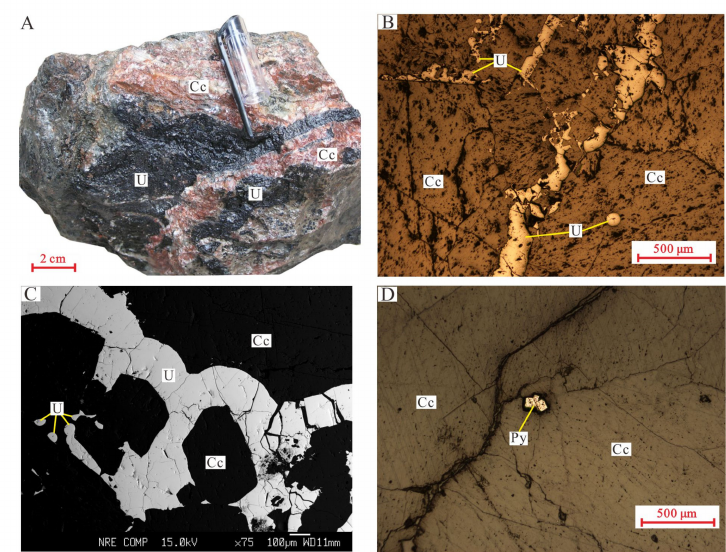
Figure 3. Vein uranium ore with calcite (Cc) as the main gangue mineral in vein-type uranium ores. ( A ): Pitchblende (U) occurs in the center or periphery of veins and forms a banded structure with carbonate minerals. ( B , C ): Pitchblende occurs in or between calcite crystals, and the crystal boundaries between pitchblende and calcite are clear and straight. ( D ): Pyrite aggregates (Py) with good crystalline morphology are encapsulated in calcites. ( A ) is the sample of uranium ore. ( B ): 5 × , Reflected-light; ( C ): SEM image; and ( D ): 5 × , Reflected-light. Sample No. M17-126.